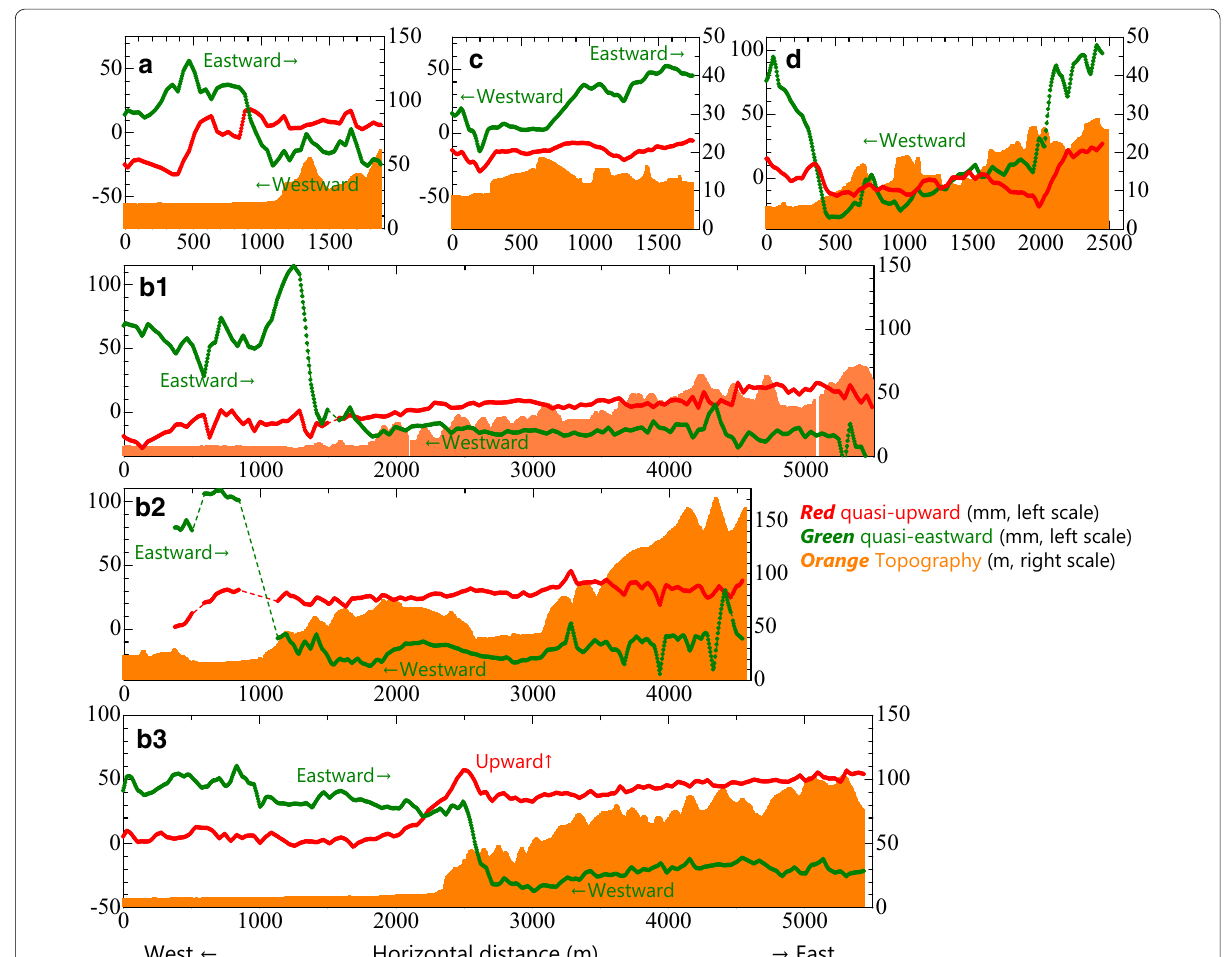
Fig. 7 Cross sections of quasi-upward (red lines) and quasi-eastward (green lines) displacement and topography. Panels a , b1 – b3 , c , and d show the cross sections marked in Figs. 5 and